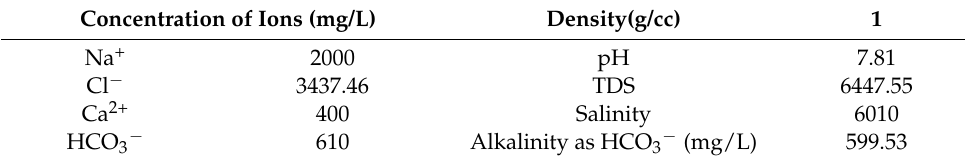
Table 1. Composition of synthetic produced water (PW).